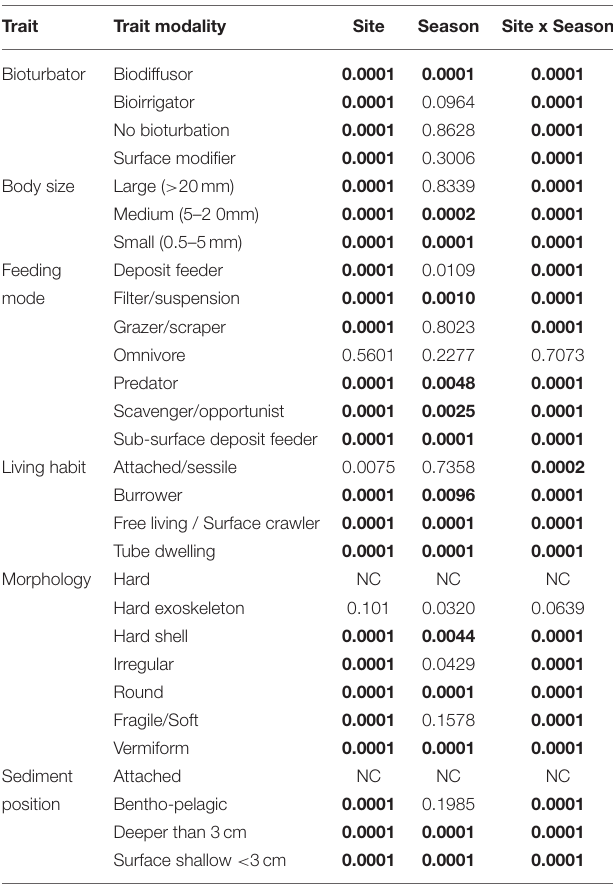
TABLE 4 | Summary of the test results from univariate one-way fixed factor PERMANOVA to CWM trait modalities across sites and seasons.